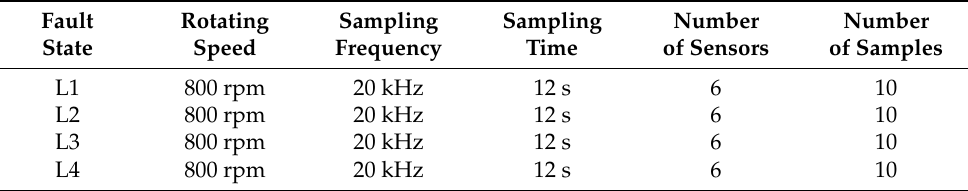
Figure 9. The preset failure modes: ( a ) Ring gear, ( b ) Planet gear, ( c ) Sun gear.